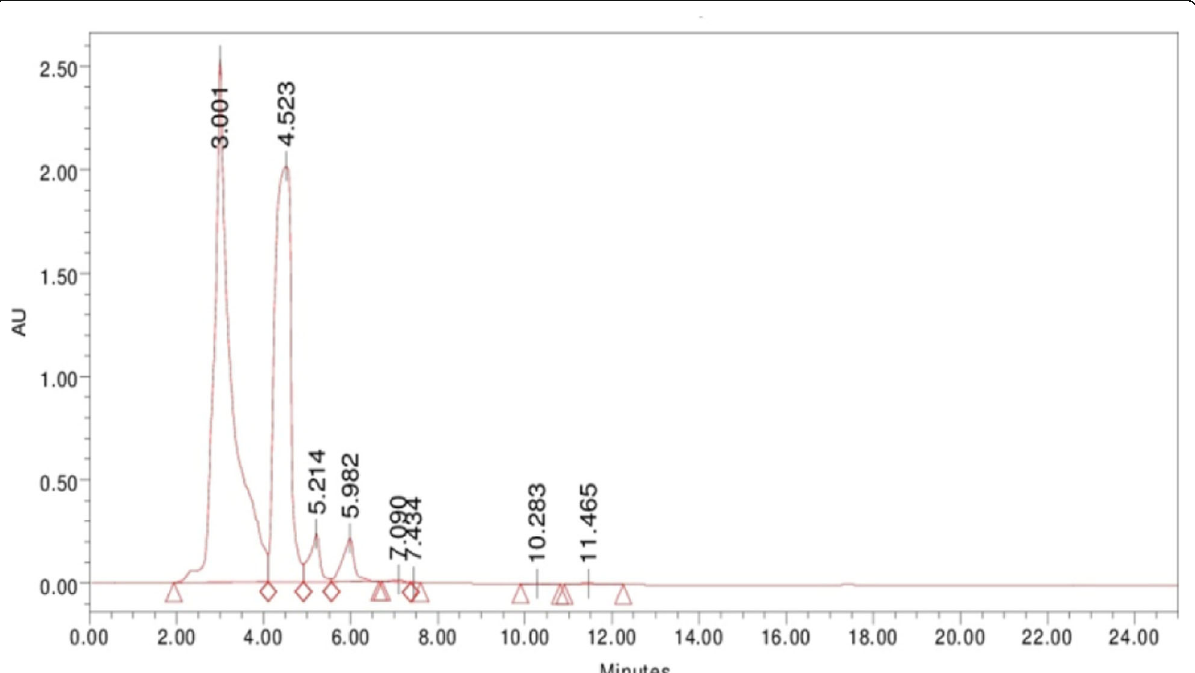
Fig. 9 Elution of polyphenols profile in bioactive F-D in HPLC. Major peaks were detected at 3.001 min and 4.523 min the elution was permitted up to 30